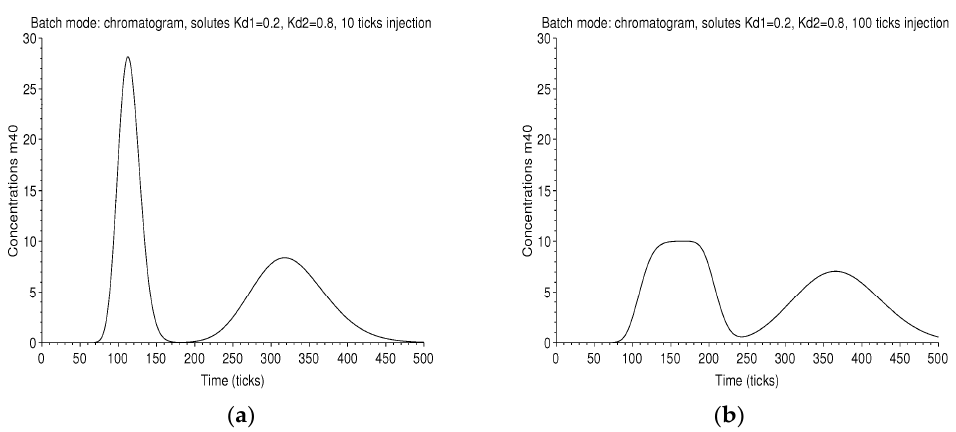
Figure 8. Batch mode: on the left graph ( a ), the chromatogram measured at the outlet of the column of 40 plates is displayed, with a retention ratio (cid:101) m = 0.1, an unit plate volume V c = 1, an amount Q inj = 2.5. The first peak corresponds to the solute of K d 1 = 0.2 and the next one to that of K d 2 = 0.8, for an injection 10 ticks long. On the right graph ( b ), the injection is 100 ticks long. The two peaks are larger and are not completely resolved.